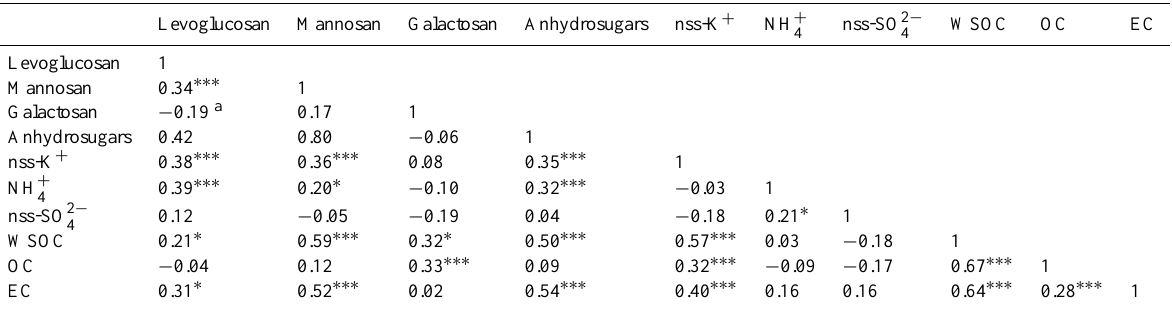
Table 2. Linear correlation coefficients ( r) among anhydrosugars, major ions and carbonaceous components in Okinawa aerosols from October 2009 to February 2012.